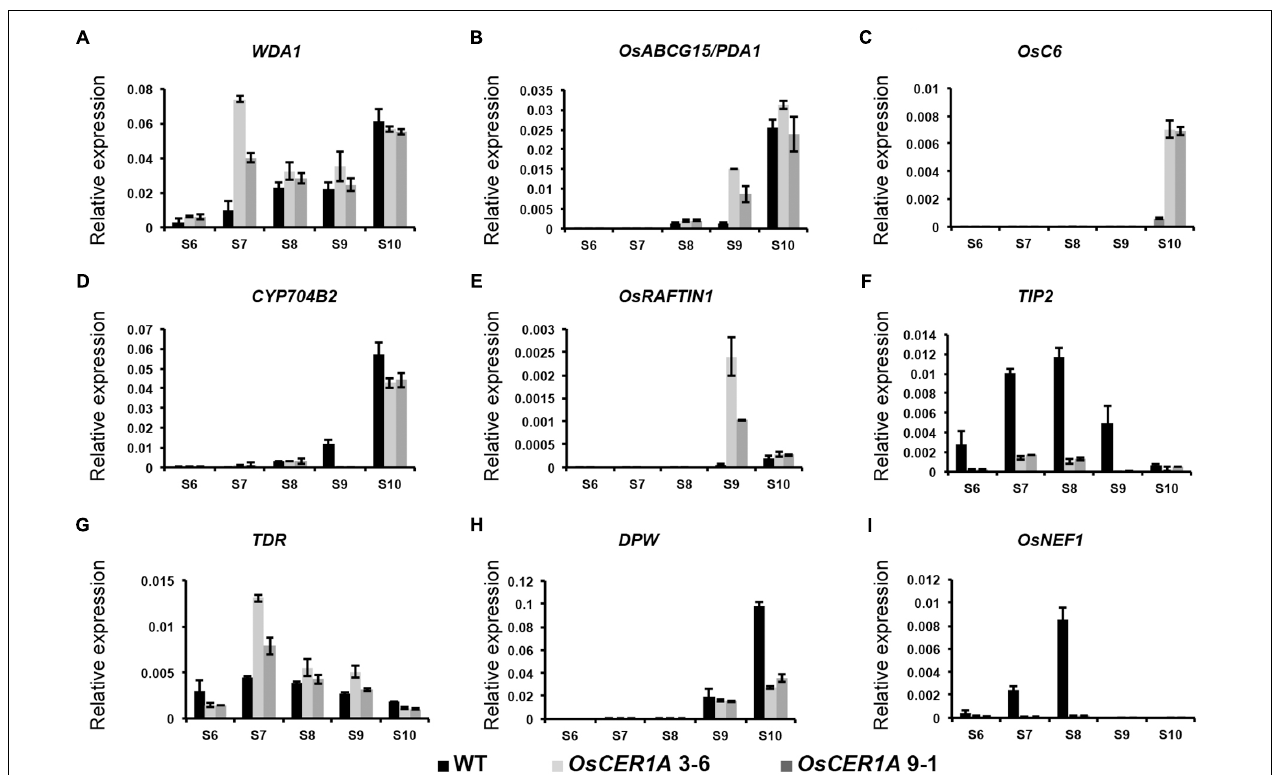
FIGURE 9 | Expression analysis of genes related to lipid metabolism and pollen wall biosynthesis in the WT and OsCER1A lines by qRT-PCR. (A–I) Expression analysis of WDA1 (A) , OsABCG15/PDA1 (B) , OsC6 (C) , CYP704B2 (D) , OsRAFTIN1 (E) , TIP2 (F) , TDR (G) , DPW (H) , and OsNEF1 (I) in the WT, OsCER1A 3-6 and OsCER1A 9-1 plants with anthers from stages 6 to 10. OsActin1 was used as a control. Black bars represent the WT plants. Slightly gray bars represent the OsCER1A 3-6 plants. Darkly gray bars represent the OsCER1A 9-1. Each reaction had three biological repeats. Error bars indicate SD ( n = 4). Gene names are abbreviated as follows: DPW , Defective Pollen Wall ; OsABCG15/PDA1 , Rice ATP binding cassette subfamily G 15/ Post-meiotic deficient anther 1 ; OsNEF1 , Rice No Exine Formation 1 ; TDR , Tapetum Degeneration Retardation ; TIP2 , TDR Interacting Protein 2 ; WDA1 , Wax-deficient Anther 1